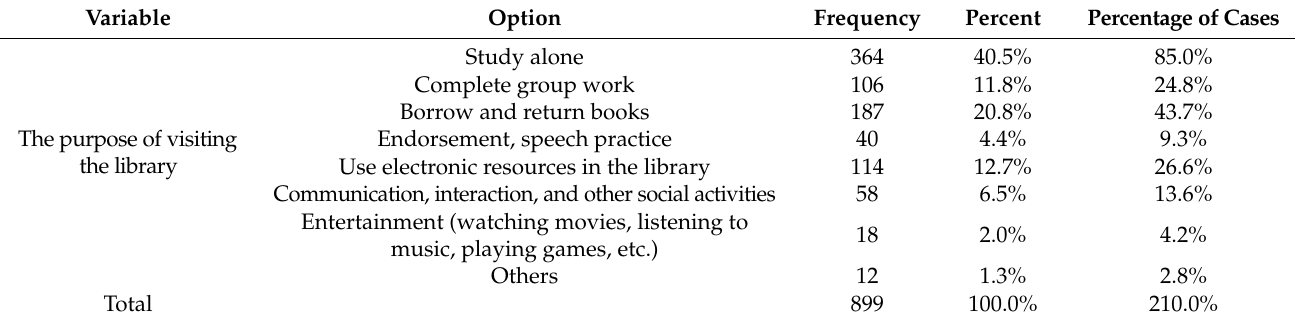
Table 9. Descriptive statistics of the purpose for visiting the